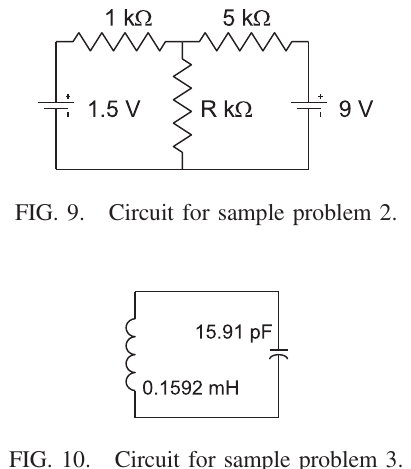
FIG. 10. Circuit for sample problem 3.